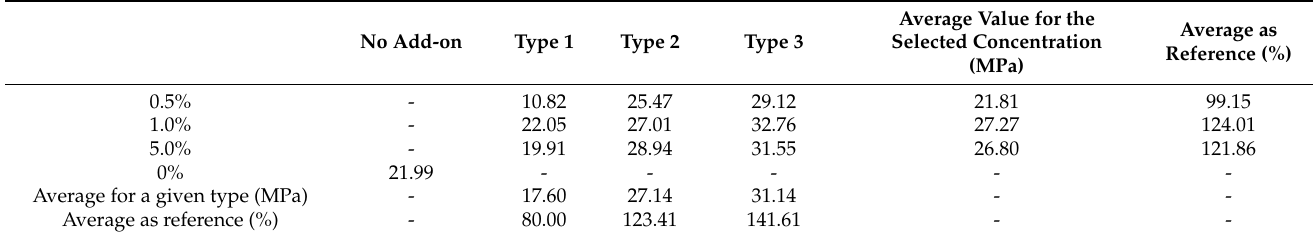
Table 4. Change in the strength of samples in relation to the unmodified